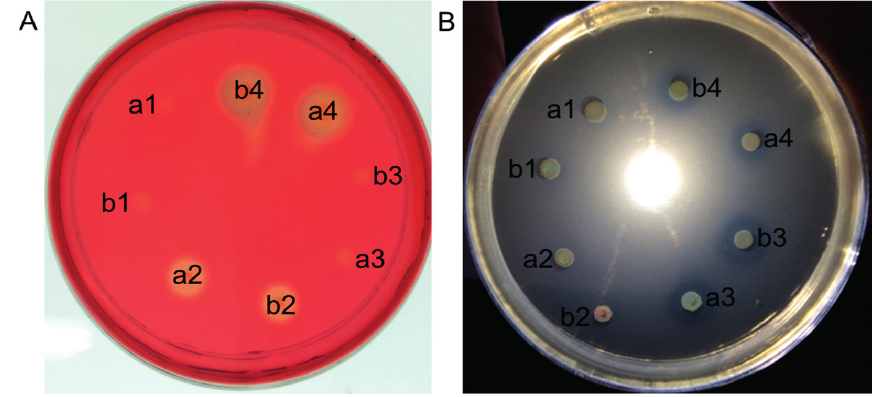
Figure 3. Plate test for endoglucanase and phytase activity of Lactobacillus reuteri transformants. Extracellular supernatant ( A ) and intracellular extract ( B ) of growing cells were pipetted into wells of a CMC-containing plate stained with Congo red a and into wells of a sodium phytate-containing plate b. Well 1 , L. reuteri pLEM4156; well 2 , L. reuteri pLEM4157 (cel); well 3 , L. reuteri pLEM4159-cel/phy; well 4 , L. reuteri pLEM4158 (phy).